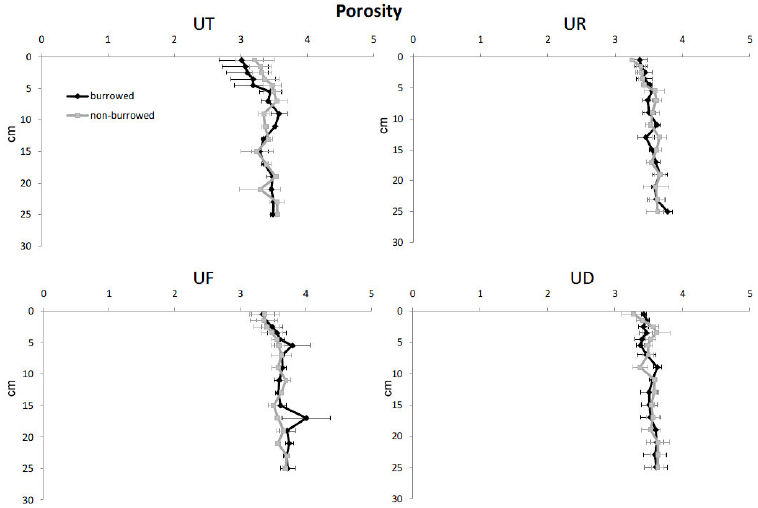
Figure 2. Vertical distribution of porosity in burrowed and non-burrowed sediments of U. triangularis (UT), U. rosea (UR), U. forcipata (UF) and U. paradussumieri (UD) habitat.